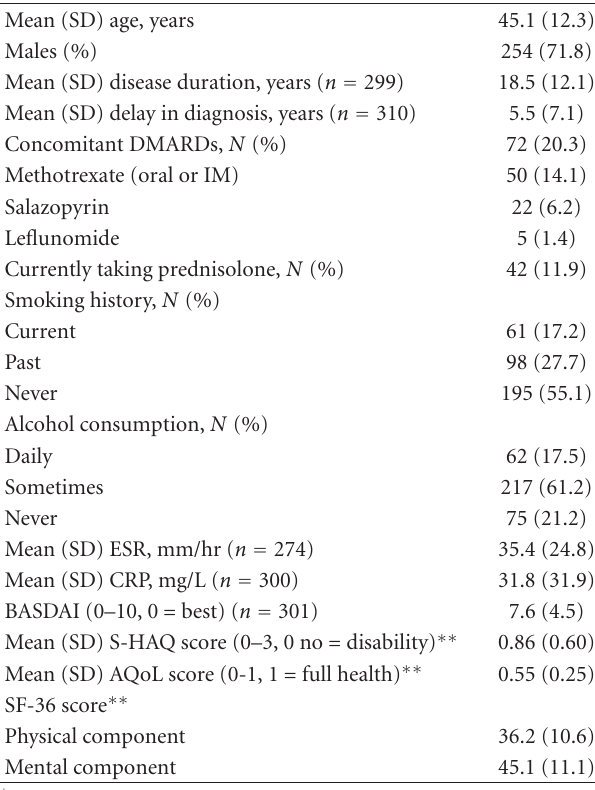
Table 1: Baseline demographic and clinical characteristics of AS patients enrolled in ARAD who have been exposed to biological therapy ( n = 354) ∗